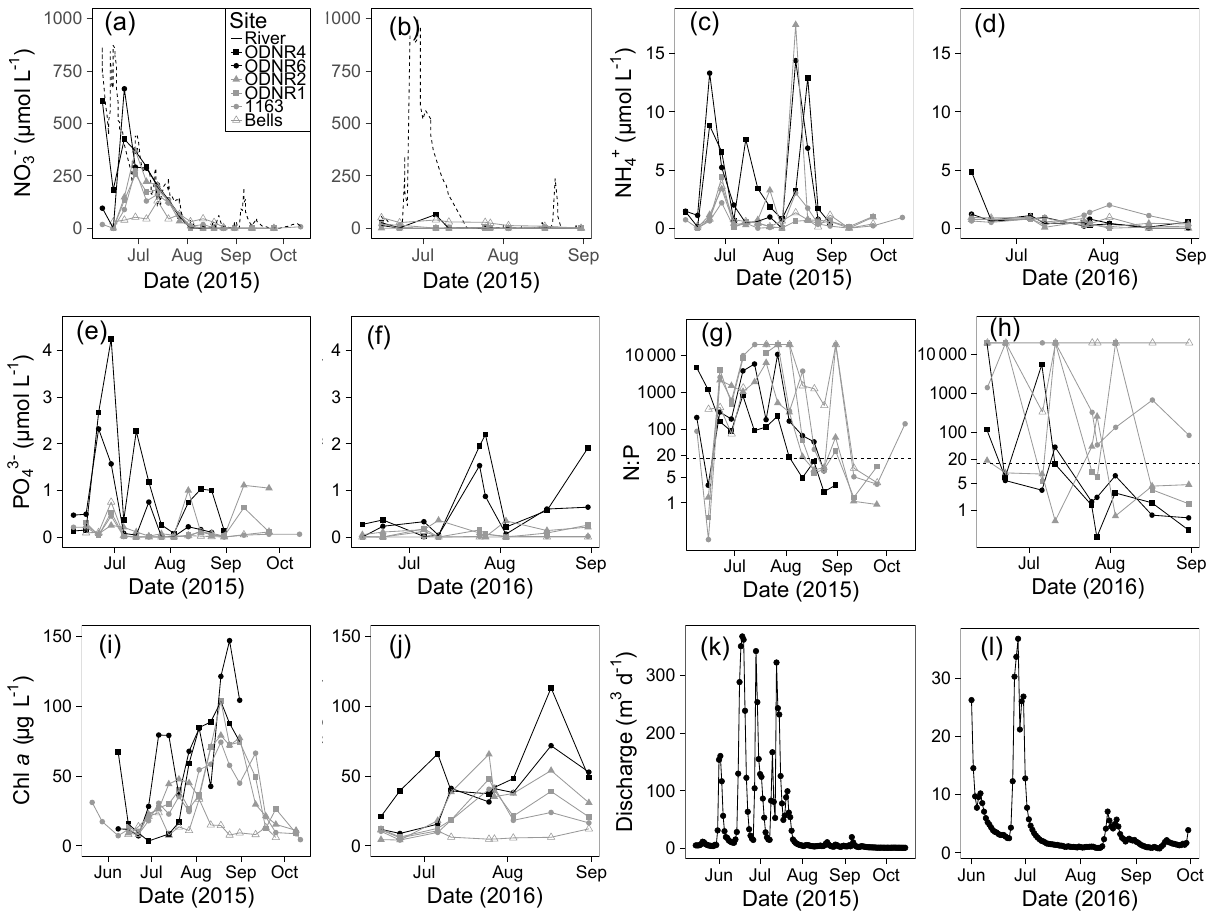
+ NH + : PO 3 − Figure 2. (a, b) NO − , (c, d) NH + , (e, f) PO 3 − , (g, h) N : P (NO − ) ratio, (i, j) chlorophyll a , and (k, l) Sandusky River 3 4 4 3 4 4 discharge, in 2015 and 2016. Six Sandusky Bay sites are presented: the inner bay (ODNR and ODNR6; black filled symbols), the outer bay (ODNR2, ODNR1, and 1163; gray filled symbols), and a site outside the bay in the central basin of Lake Erie (Bells; gray open symbols). NO − concentrations in the Sandusky River are presented as a dotted line (a, b) . Note the consistent scales between years for single variables 3 (exception: discharge) but differing scales among variables. The dotted line in (g, h) indicates a N : P ratio of 16 (note log scale on y